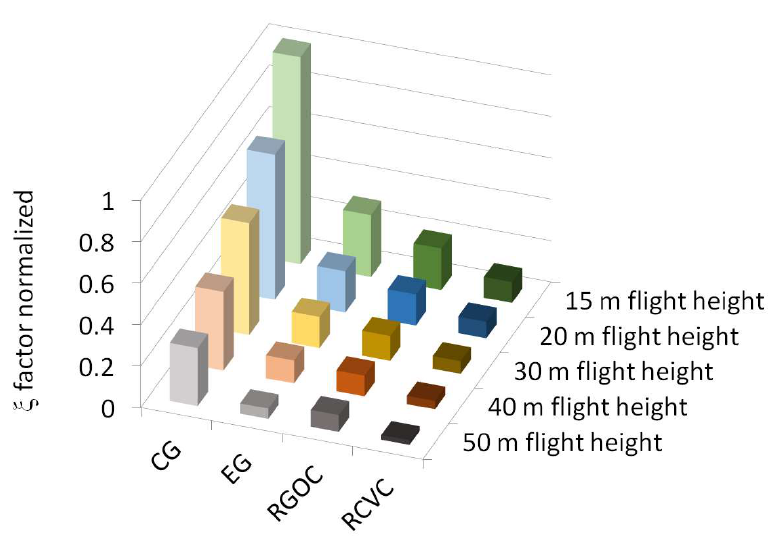
Figure 14. 𝜉 factor normalized. Figure 14. ξ factor